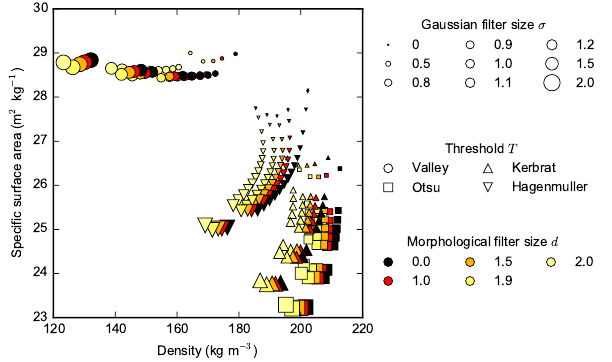
Figure 8. SSA and density of image G2-s1 obtained by sequential filtering for different segmentation parameters.